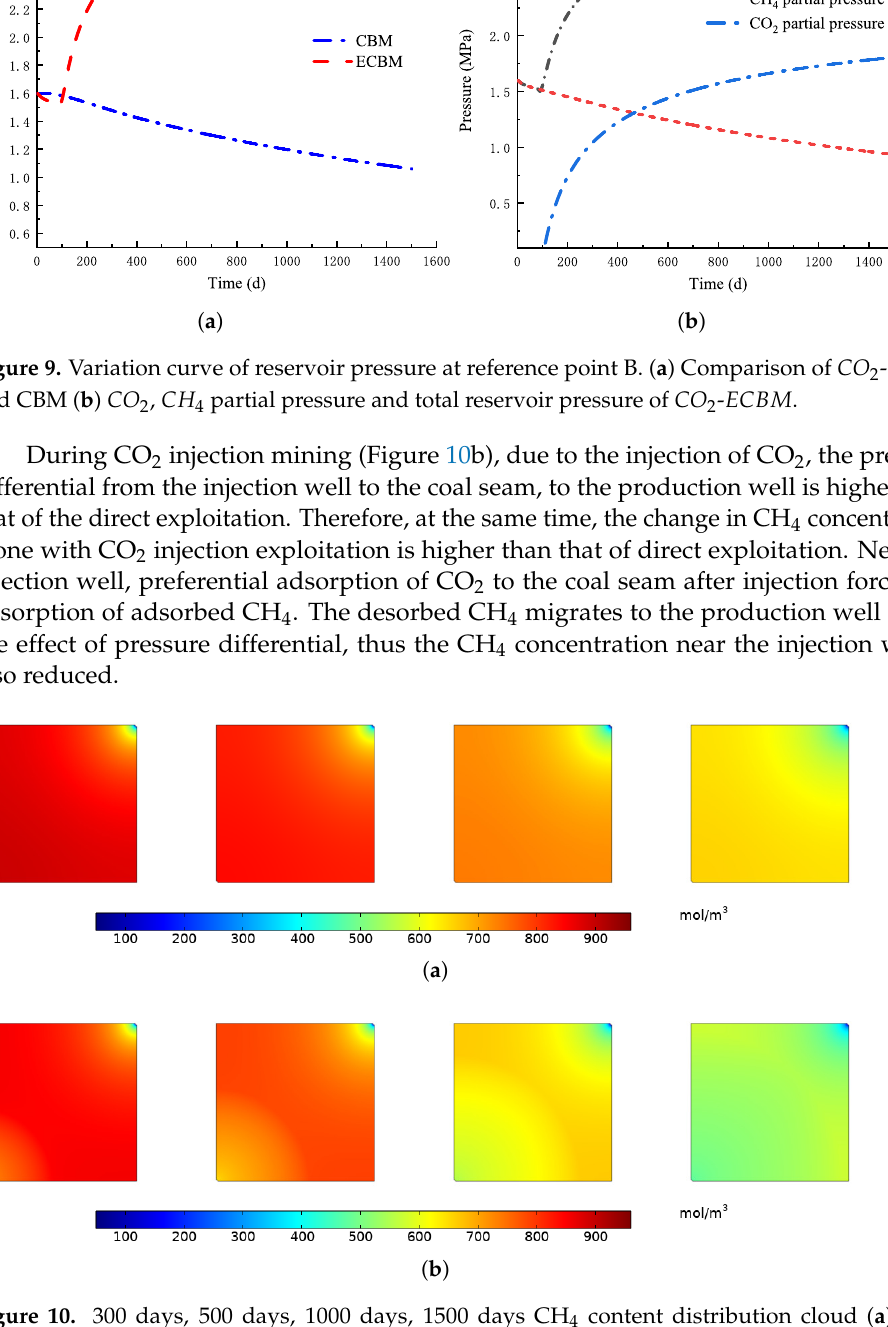
Figure 10. 300 days, 500 days, 1000 days, 1500 days CH 4 content distribution cloud ( a ) CBM ( b ) CO 2 - ECBM